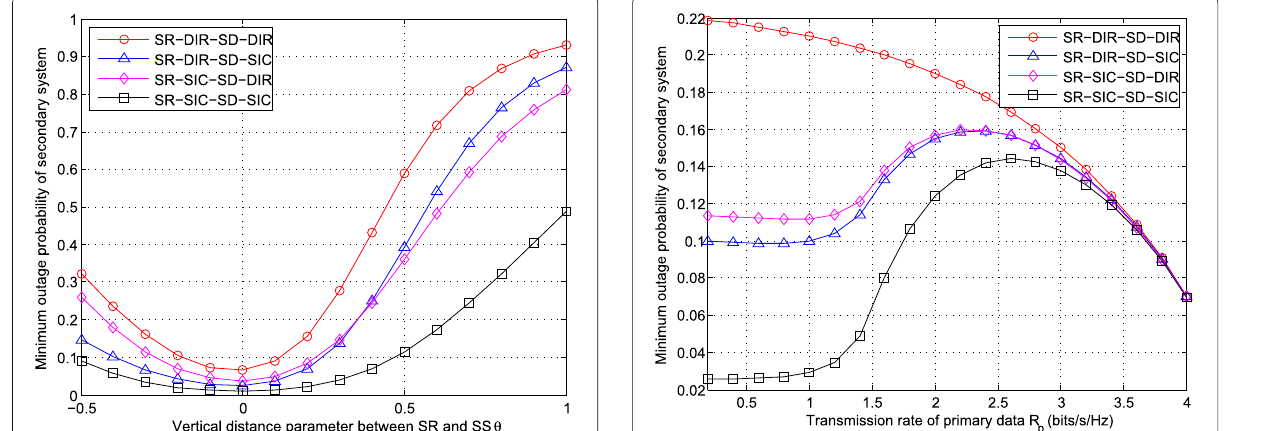
secondary system gets larger, as it becomes more dif- ficult to correctly decode the secondary at SR and SD.